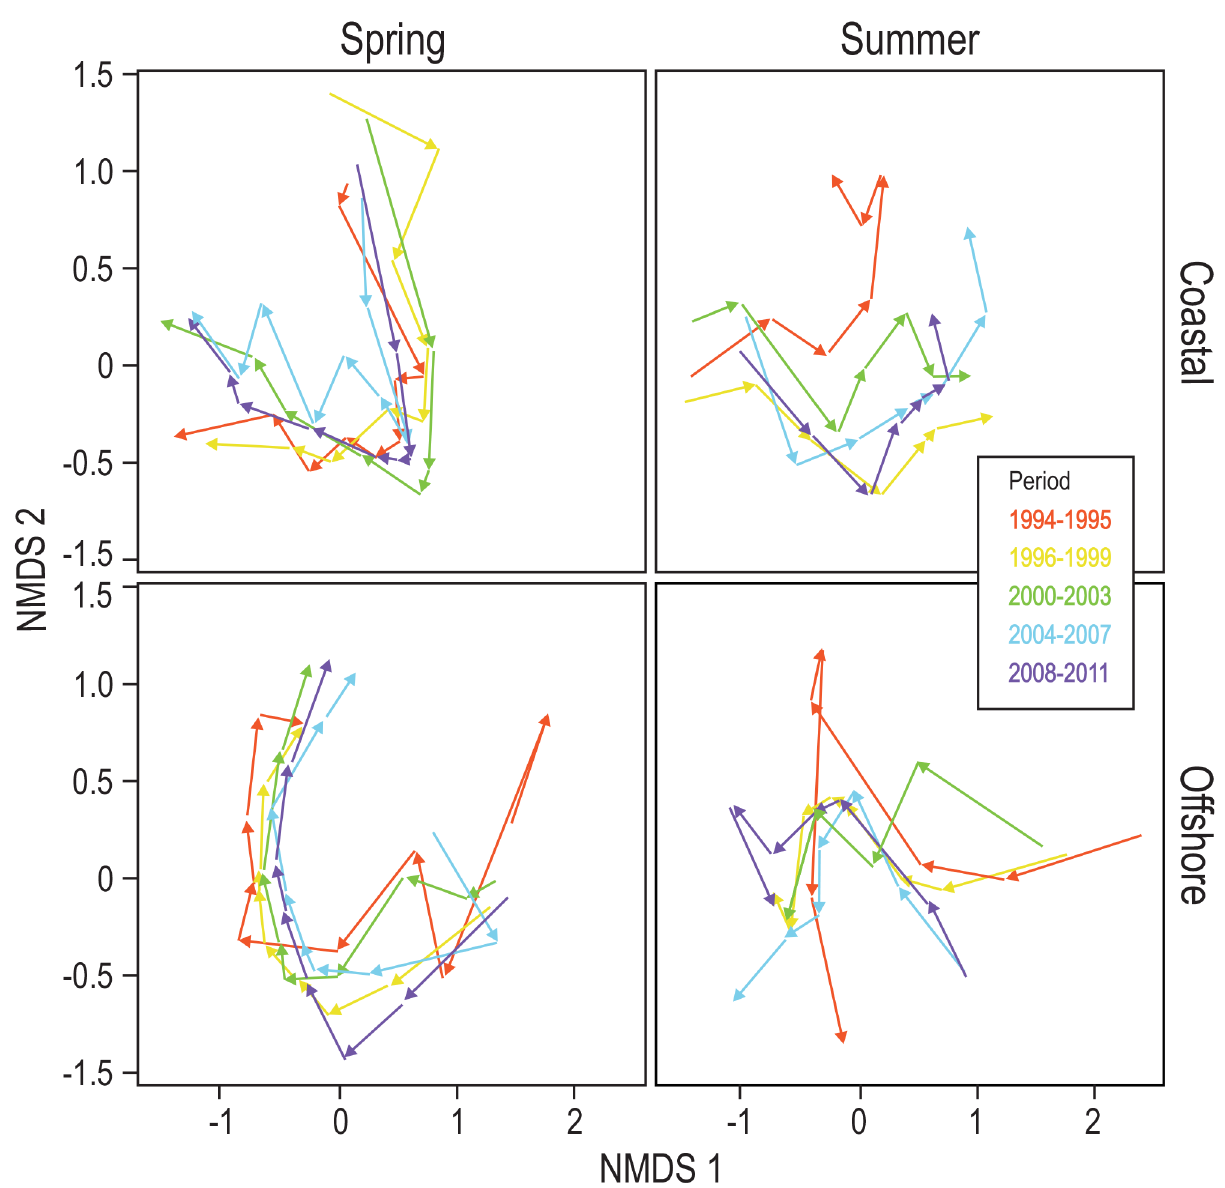
Fig 5. Multivariate ordination. Nonmetric multidimensional scaling (NMDS) ordinations showing community trajectories during spring and summer sampling occasions in the coastal and offshore site. Different colors represent averaged time periods. The length of each arrow reflects community change from one sampling event to the